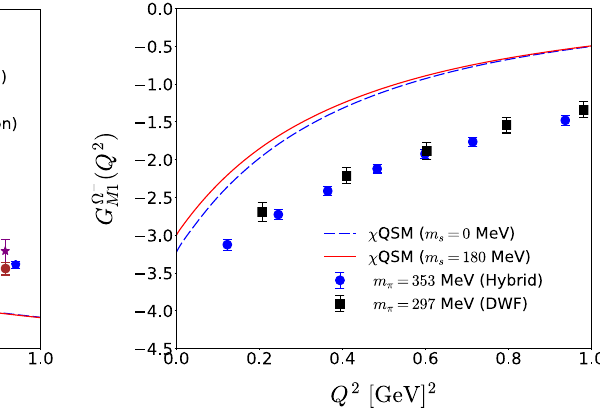
whereas the solid ones present the E 0 form factors with the effects. The lattice data are taken from Refs. [21,23,24]. Notations are the same as in Fig.